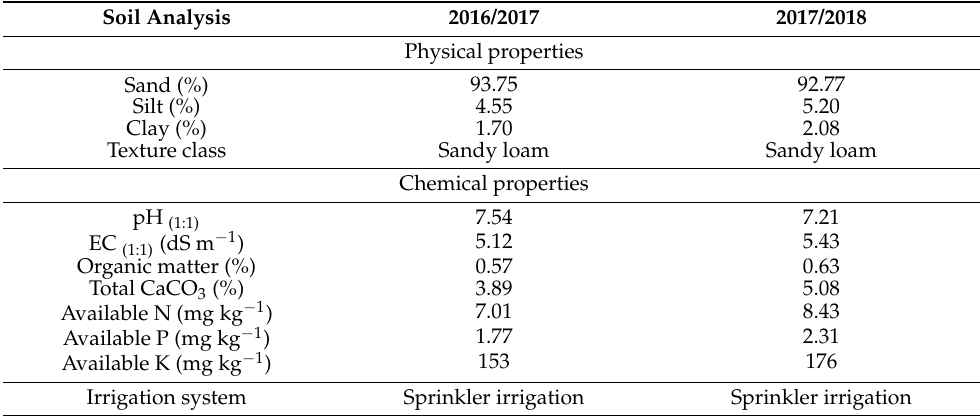
Table 2. Soil properties at the experimental site during 2016/2017 and 2017/2018 seasons. Soil Analysis